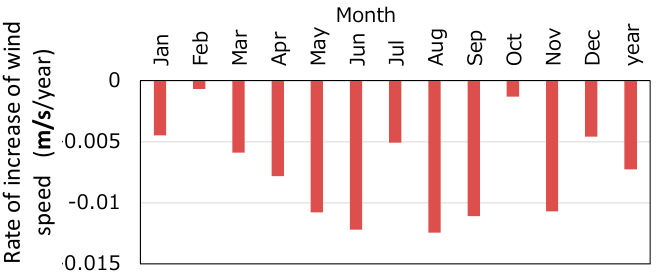
Figure 12. Rate of increase over time in the monthly averages of wind speed for each month (1990 − 2019). Wind speed: same as Figure 11. Rate of increase in wind speed: slope of linear regression line for the monthly average temperature for each month over 30 years.